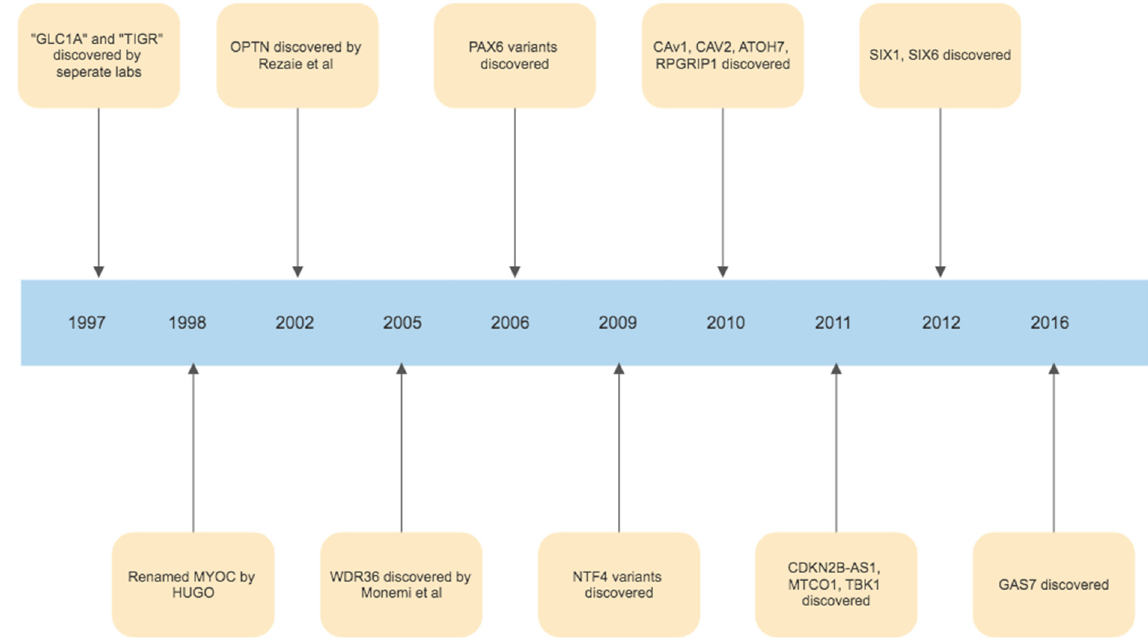
Figure 4. Timeline of gene discoveries linked to the development of glaucoma.